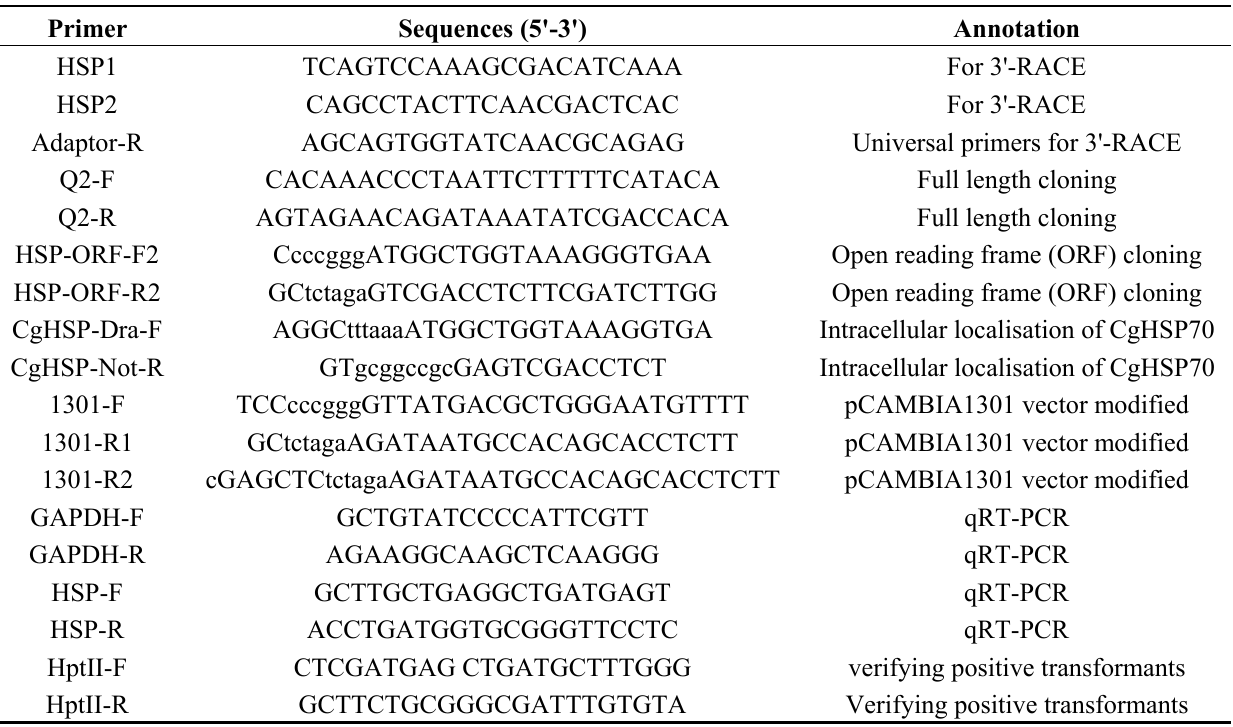
Table 2. The PCR primers used in this